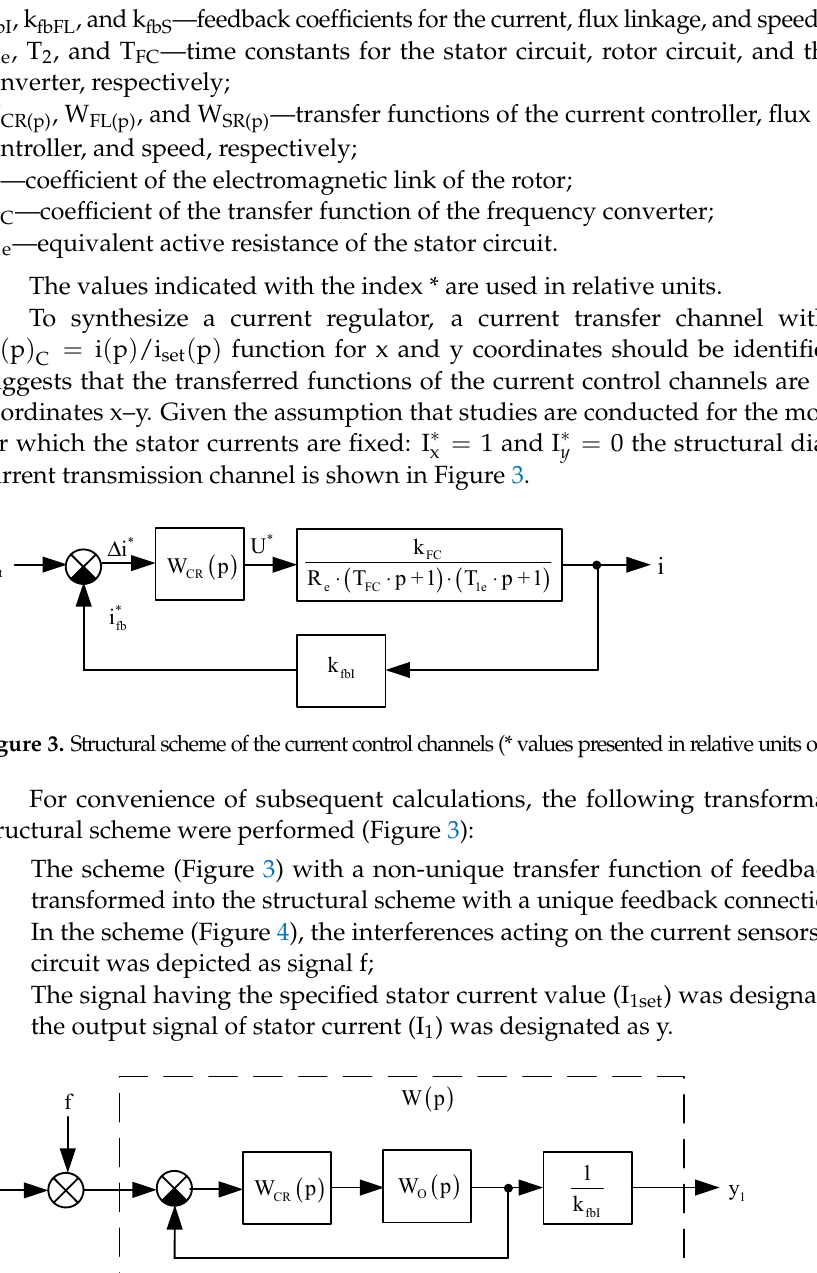
Figure 2. The structural scheme of the system ‘Frequency converter—asynchronous motor’ in the case of the common coordinate system of coordinates α - β , which are oriented according to the flux linkage of the rotor.